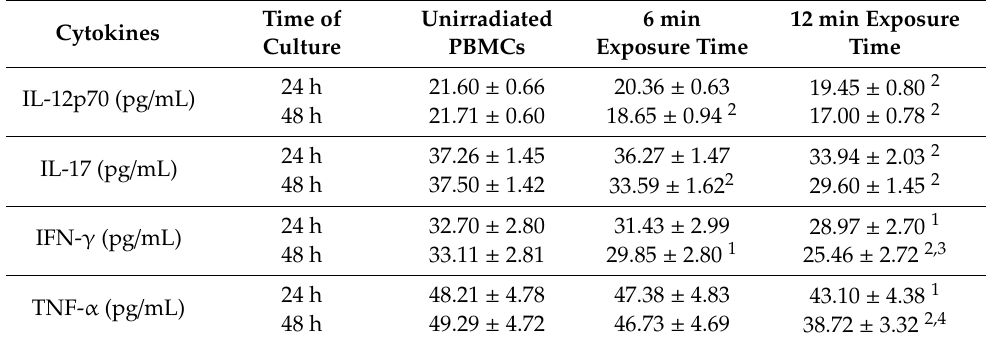
Table 1. E ff ects of exposure to a Polarized Polychromatic Incoherent Low Energy Radiation (PILER) lamp on the production of the pro-inflammatory cytokines by cultured peripheral blood mononuclear cells (PBMCs).